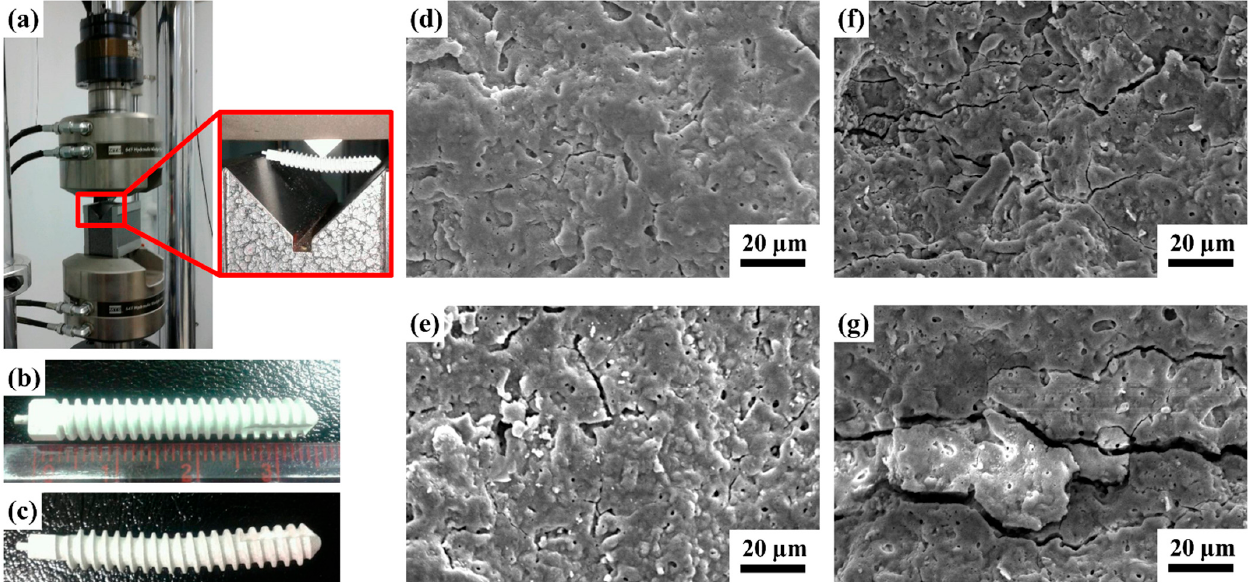
Figure 8. ( a ) Test setup for the three-point bending measurement; visual images of ( b ) before, ( c ) after testing on the ZK60 Mg alloy bone screws treated with MAOCa, and the SEM morphology of the bone screw depression distance ( d ) 0.5; ( e ) 0.75; ( f ) 1.0; ( g ) 2.0 mm. Table 3. Three-point bending measurement of the ZK60 Mg alloy bone screws treated with